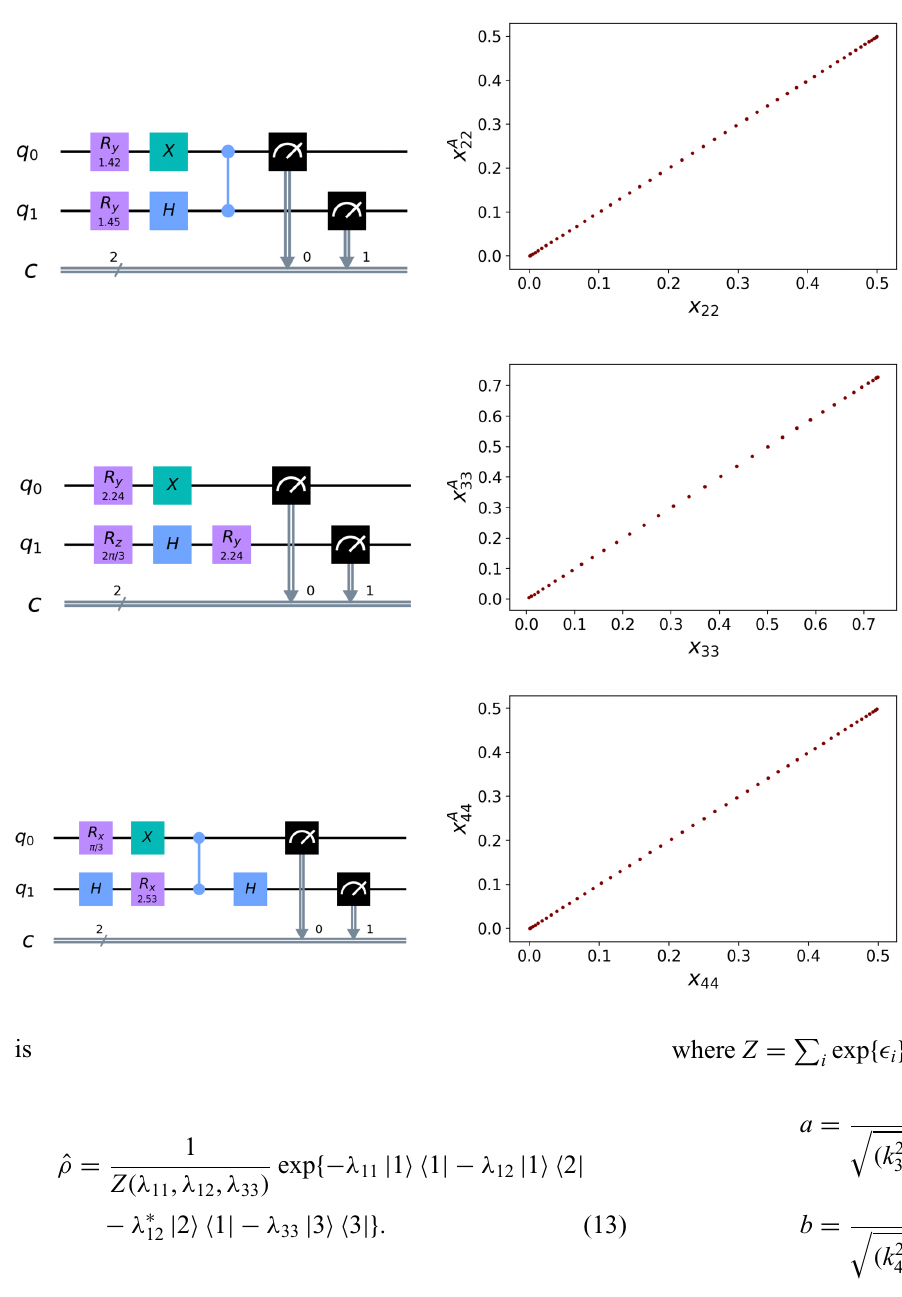
FIG. 4. The different gate mod- els and the corresponding plots between the true ( x KK ) and pre- ) mean dicted ( x A KK